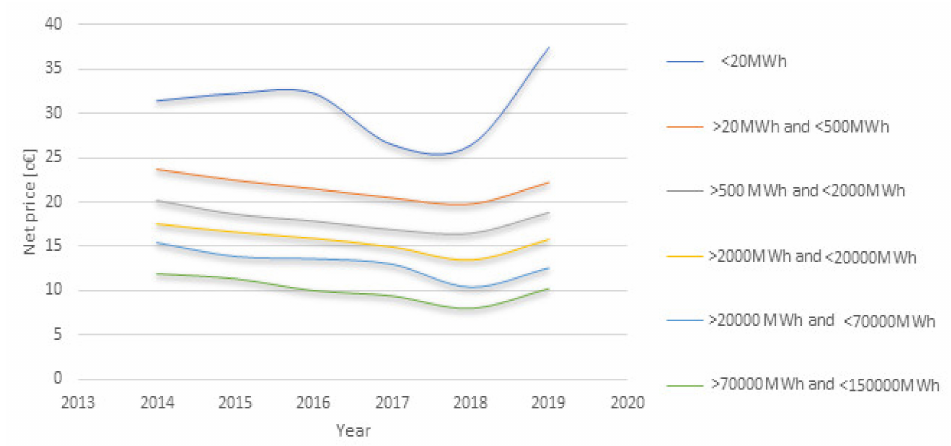
Figure 19. Gross price of energy for different ranges of annual consumption.